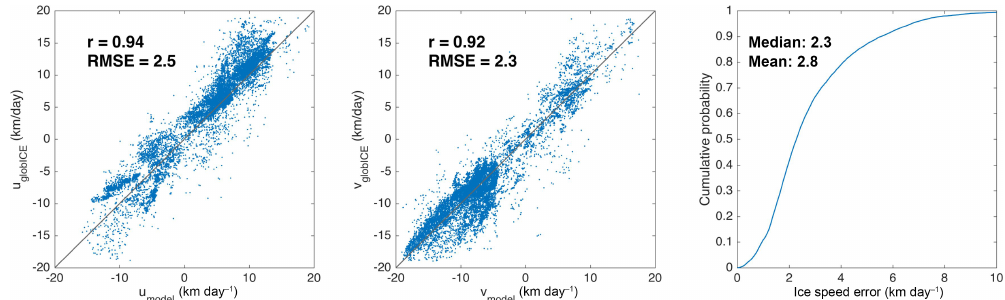
Figure 3. Scatter plots for the two components of the simulated and observed drift selected from the air drag optimisation procedure (left and middle panels). Cumulative distribution of the velocity errors (right